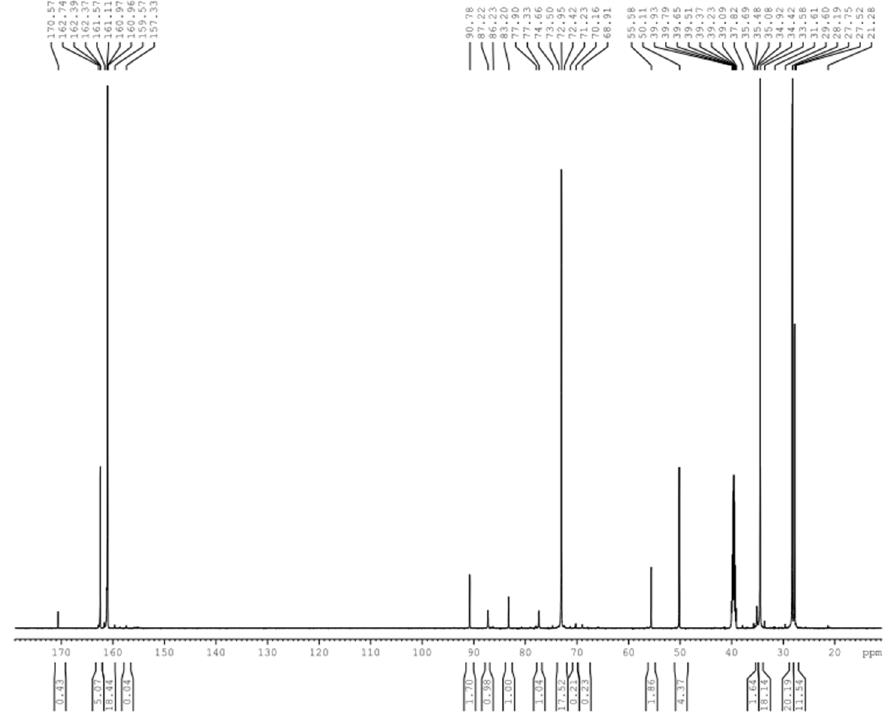
Figure 2. The 13 C-NMR spectrum of sample A1.